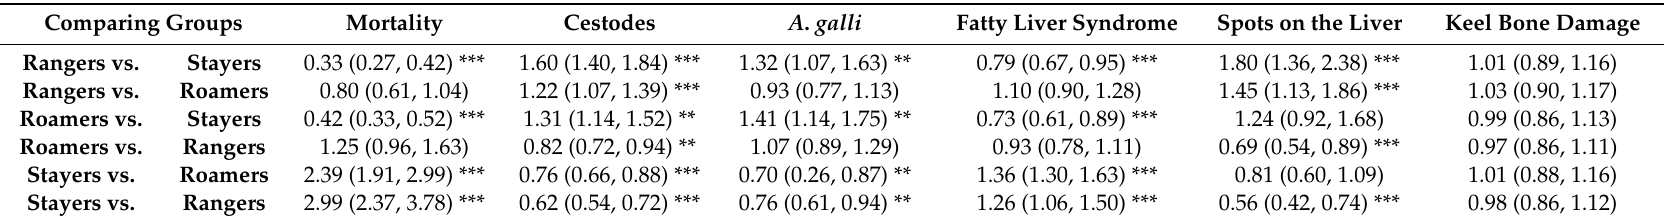
Table 2. Odds ratios for mortality, keel bone damage, cestodes and A. galli infection, fatty liver syndrome and spots on the liver comparing the results obtained from the various range groups (stayers, roamers, and rangers). The numbers in brackets represents the confidence interval at 95% of the odds ratios. Comparing Groups Rangers